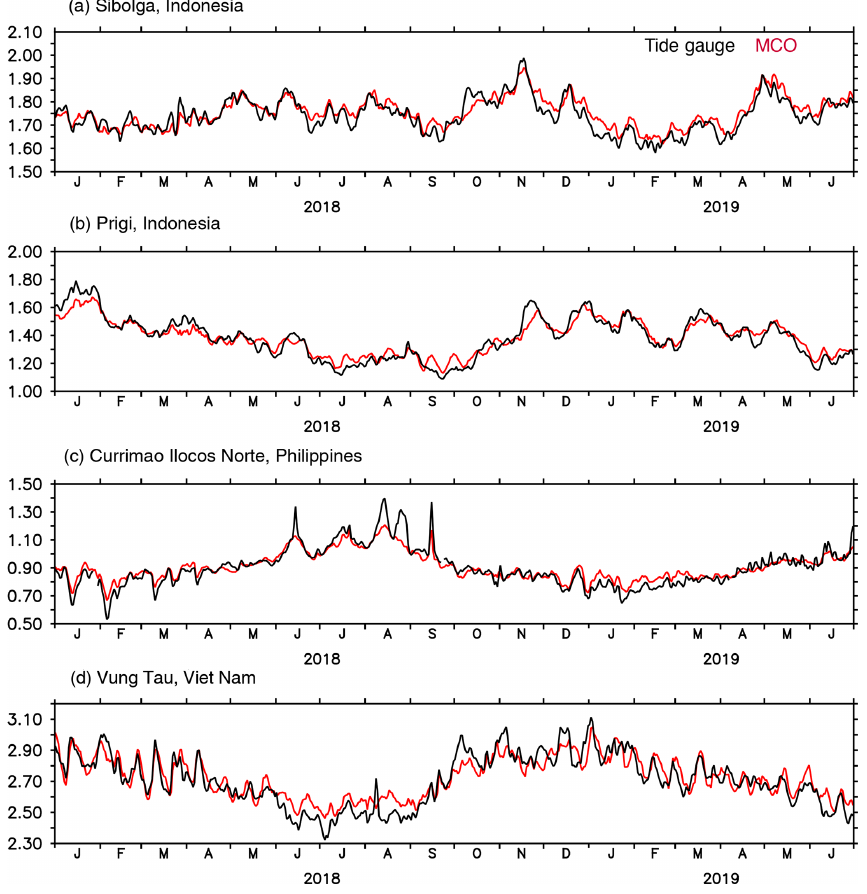
Figure 6. Time series of daily mean SSH (in metres) from tide gauge observations (black line) and MCO hindcasts (red line) at randomly selected stations, (a) Sibolga (1.75 ◦ N, 98.76 ◦ E), (b) Prigi (8.28 ◦ S, 111.73 ◦ N), (c) Currimao Ilocos Norte (17.988 ◦ N, 120.488 ◦ E), and (d) Vung Tau (10.34 ◦ N, 107.072 ◦ E), from 1 January 2018 to 30 June